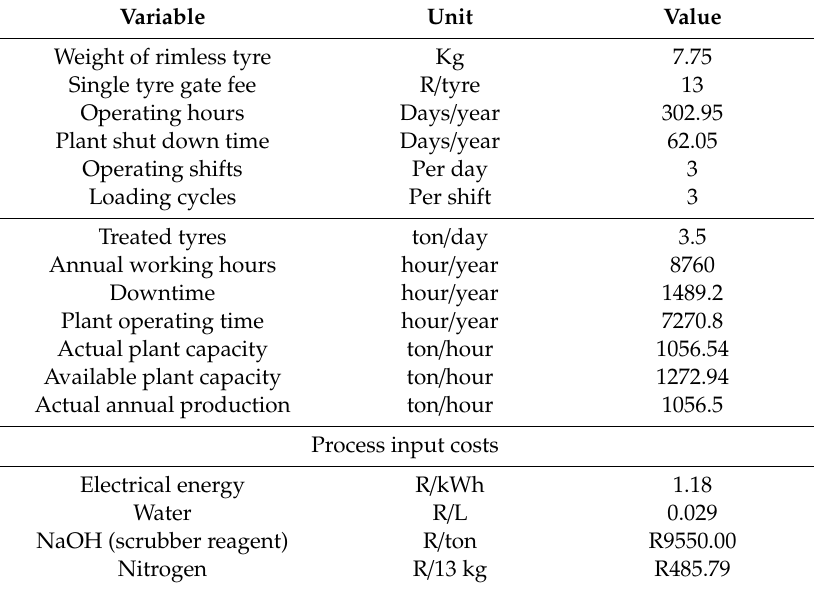
Table 7. Pyrolysis plant process assumptions, inputs, and